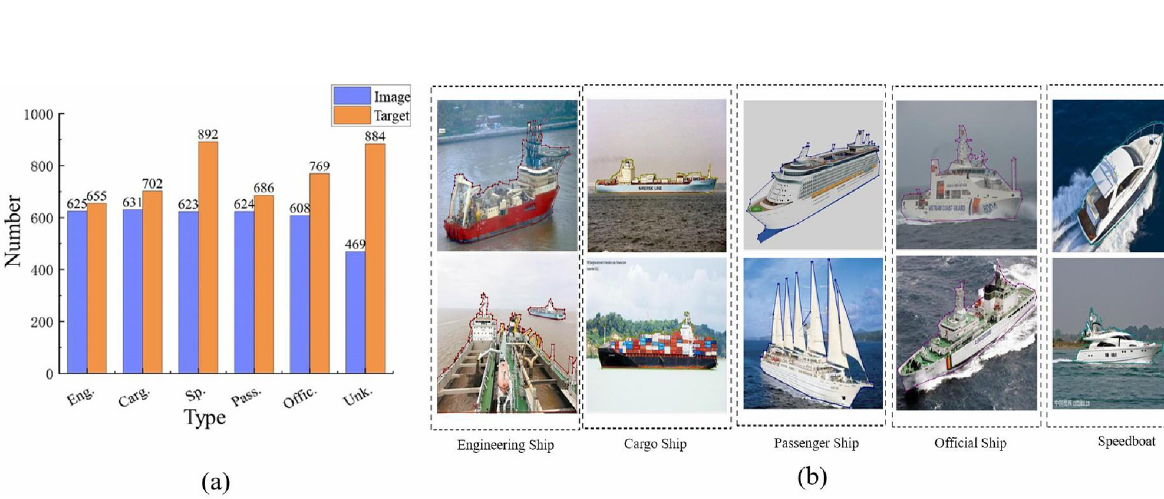
PLOS ONE | https://doi.org/10.1371/journal.pone.0279248 February 24, 2023 9 /